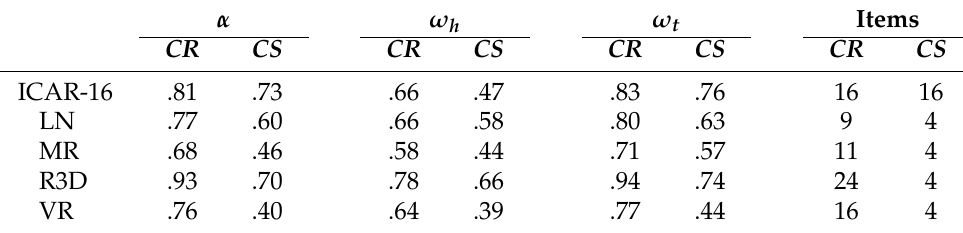
Table 2. Reliability comparisons of ICAR-16 items in current study and Condon and Revelle,